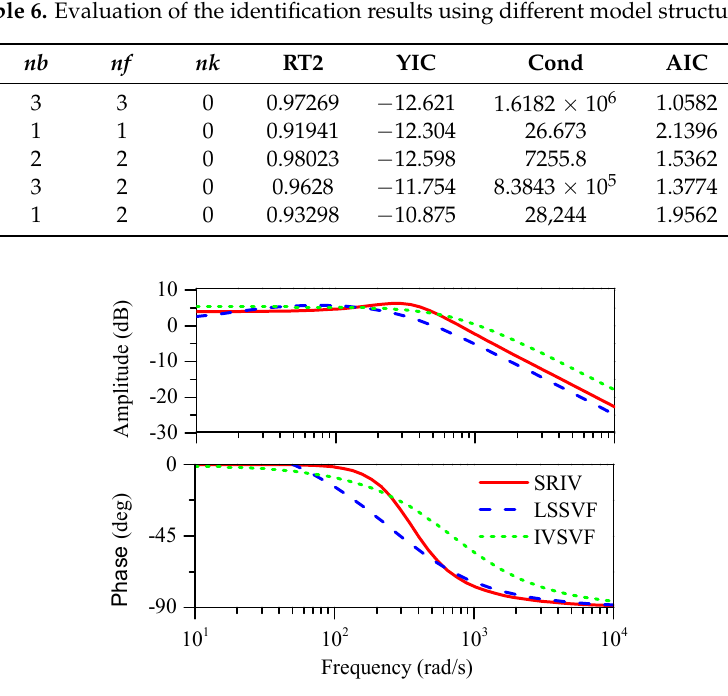
Figure 10. Bode plot using different identification algorithms.